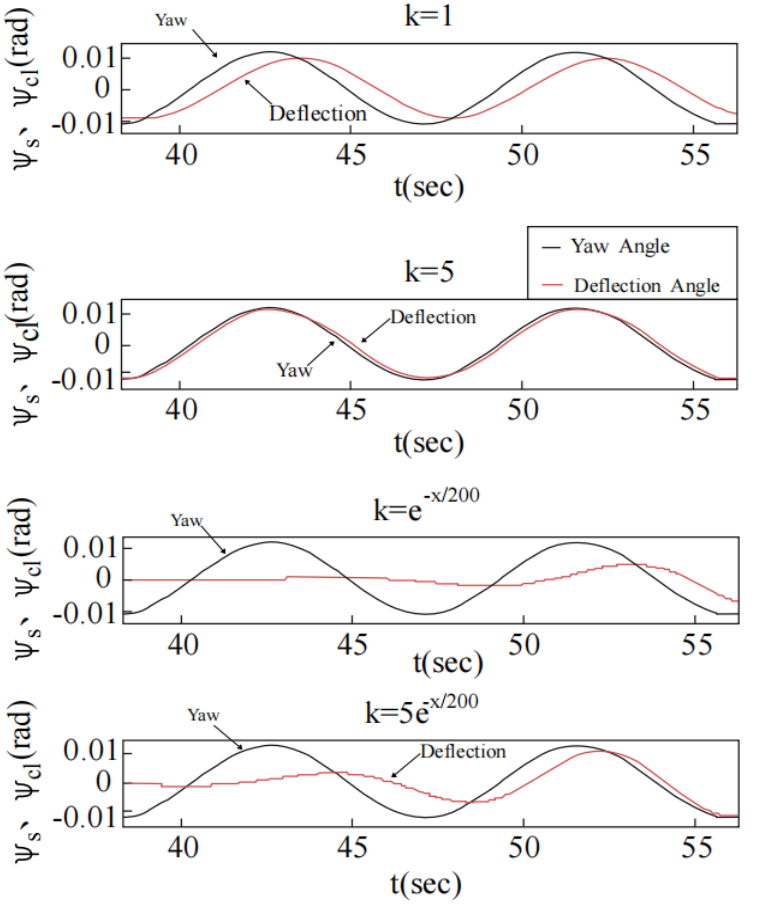
Figure 27. Tracking response curve of measurement axis under inertial tracking strategies with different values of k .